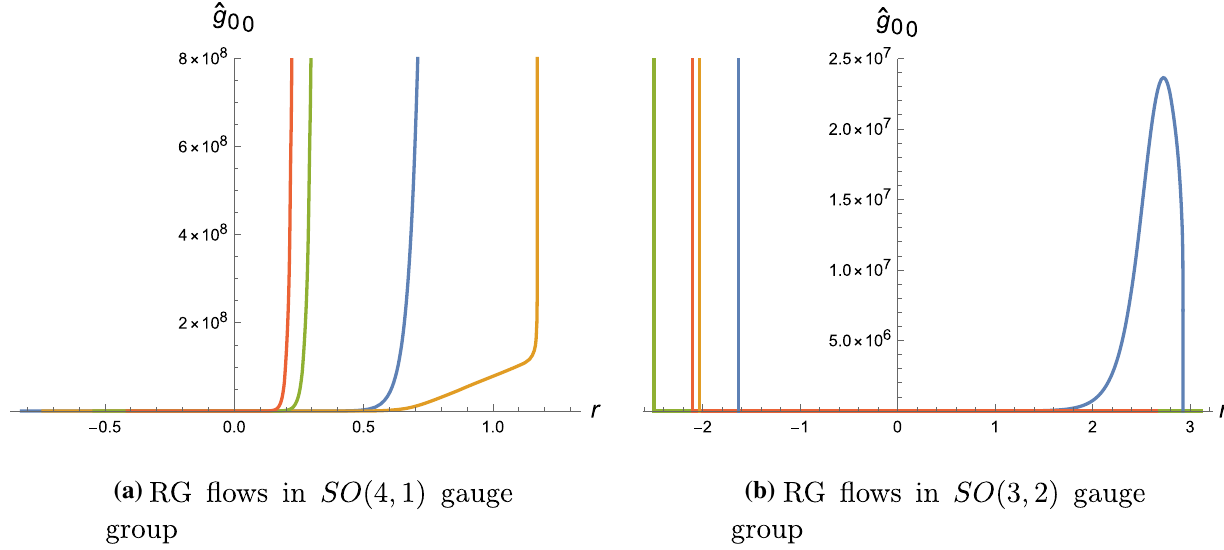
Fig. 29 Profiles of the eleven-dimensional metric component ˆ g 00 for the RG flows between AdS 3 × CP 2 fixed points and curved domain walls in SO ( 4 , 1 ) and SO ( 3 , 2 ) gauge